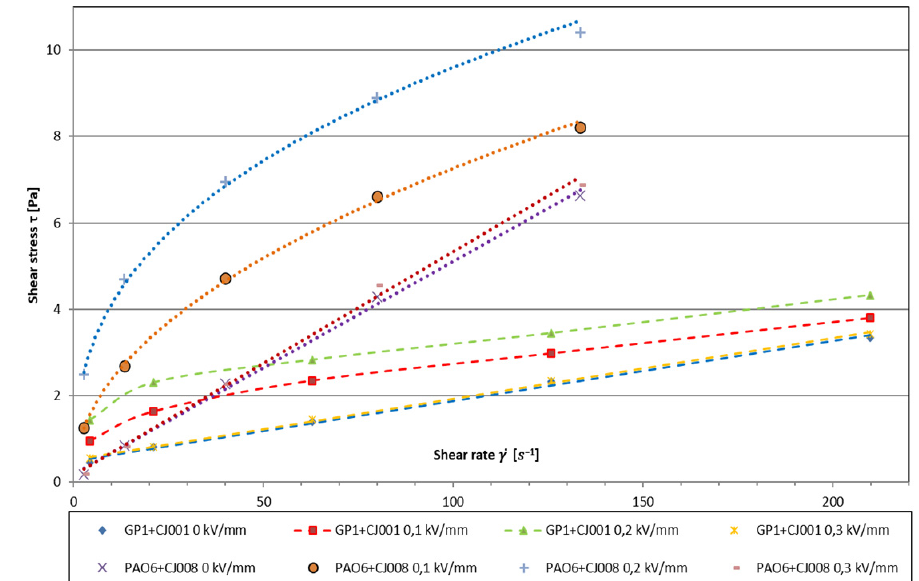
Figure 4. Characteristics τ = f( 𝛾(cid:4662) ) for mixtures GP1 + CJ001 and PAO6 + CJ008. Table 3. Results of research on ER properties of GP1 + CJ001 mixture.